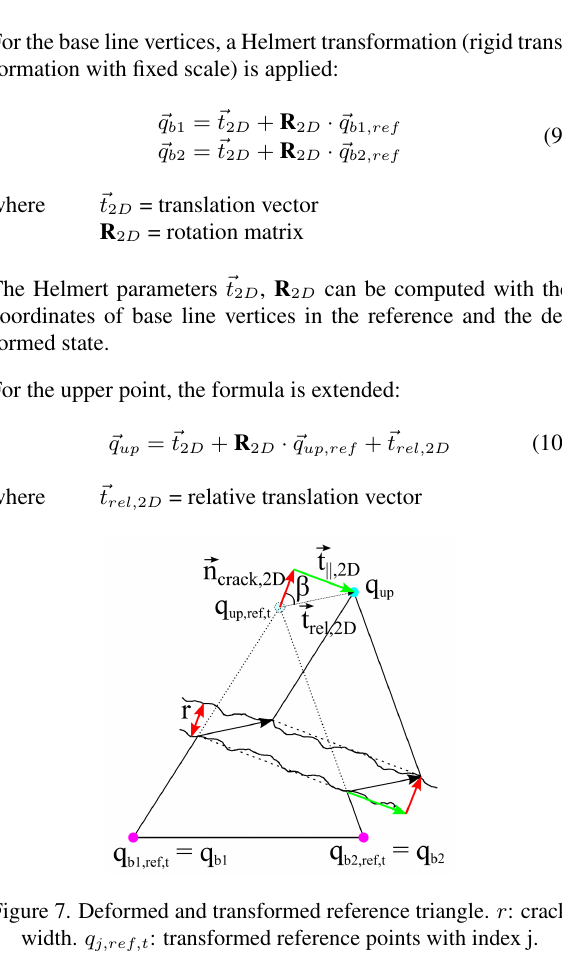
The norm of the relative translation vector || (cid:126)t rel, 2 D || is used to detect deformed triangles including cracks.